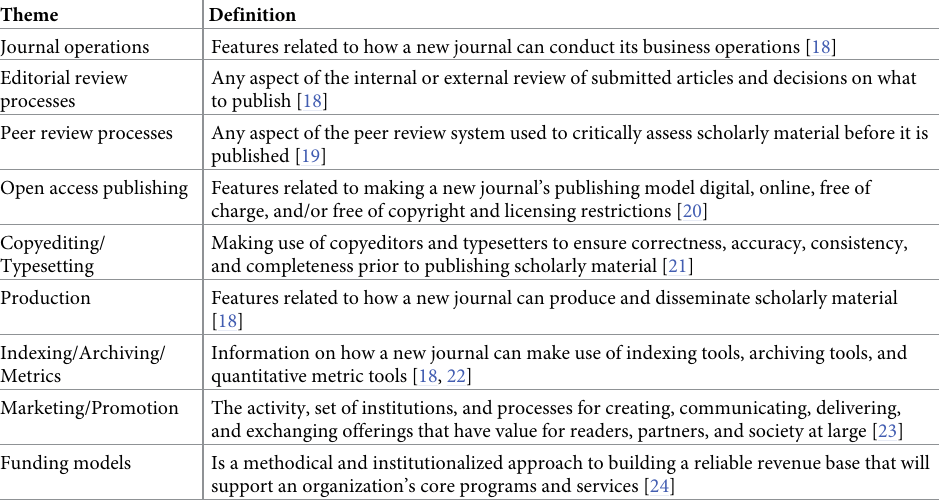
Table 6. Themes and definitions used to code categories of recommendations for creating a new scholarly